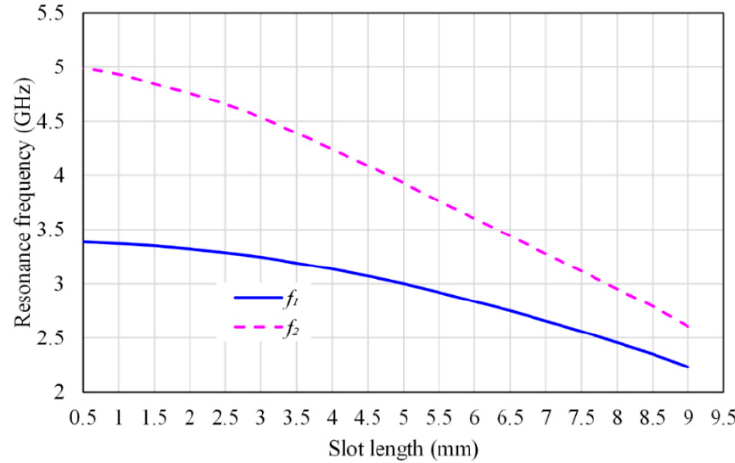
Figure 2. Resonance frequencies ( f 1 and f 2 ) variations with L S at W S = 1 mm. The same patch size of length L = 20 mm is considered in this design. Only one of the two modes, TM 100 and TM 010 , can be excited by the inset feed. The TM 100 mode is the only exciting mode if the feeder is positioned along the X -axis as shown in Figure 3.